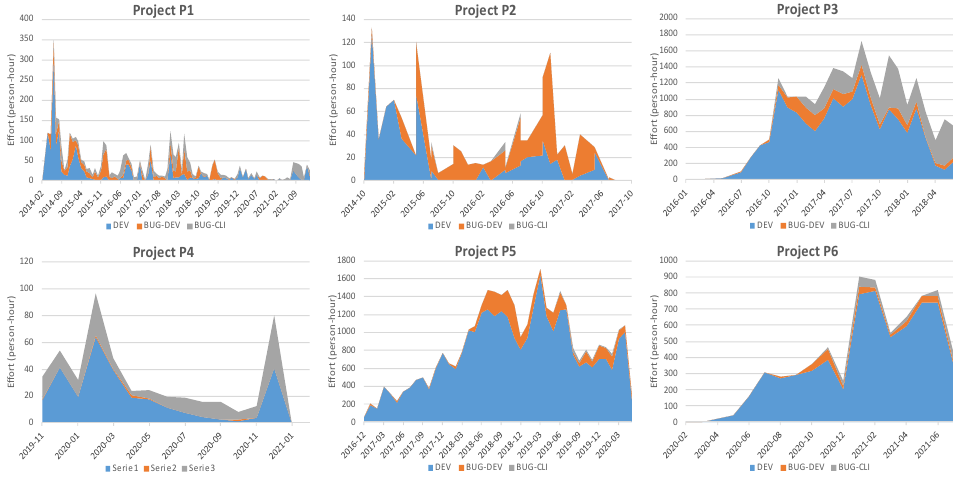
Figure 9. Work on stateful tasks in the researched projects.